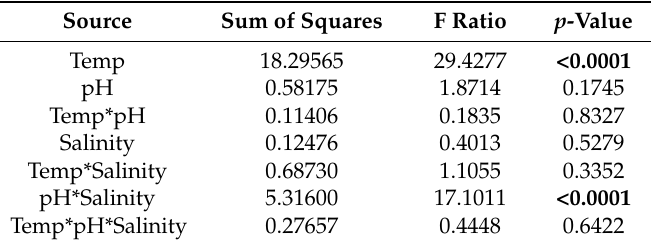
Table 4. Results of full factorial regression investigating the effect of changing temperature, pH, and rock salt concentration on mean dimensionless erosion rates (Er/u*) for a natural soil dominated by vermiculite clay minerals (r 2 = 0.45, alpha =